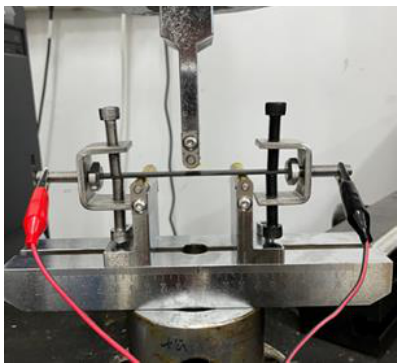
Figure 1. The configuration of the 3-point bending test under the electric-current loading.